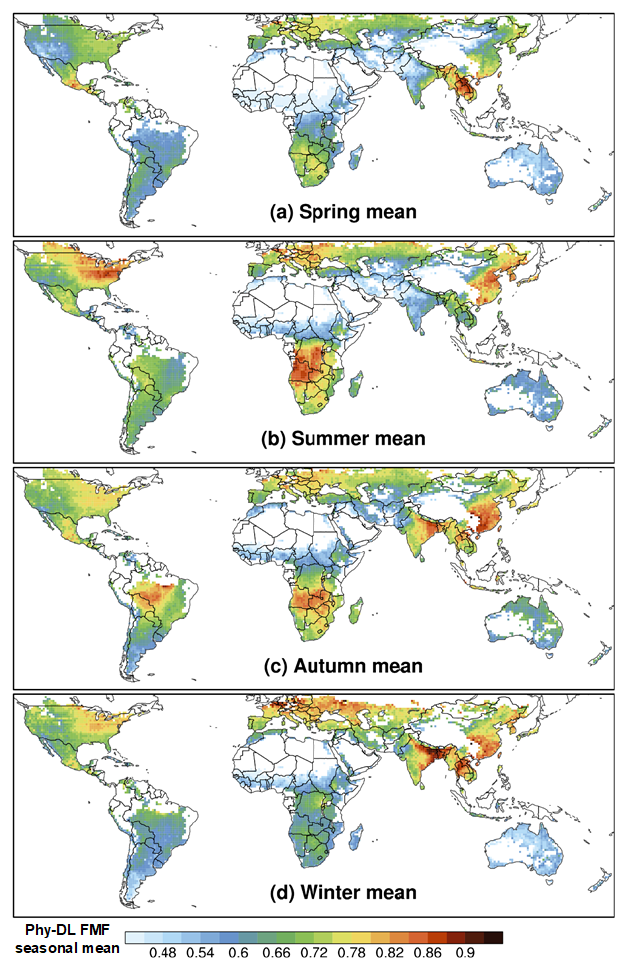
Figure 7. Phy-DL-estimated FMF seasonal mean values from 2001 to 2020. The seasons are defined as spring (March, April, and May), summer (June, July, and August), autumn (September, October, and November), and winter (December, January, and February) for both the Northern Hemisphere and Southern Hemisphere. Only those pixels with 120 retrievals per year were considered when calculat- ing the mean